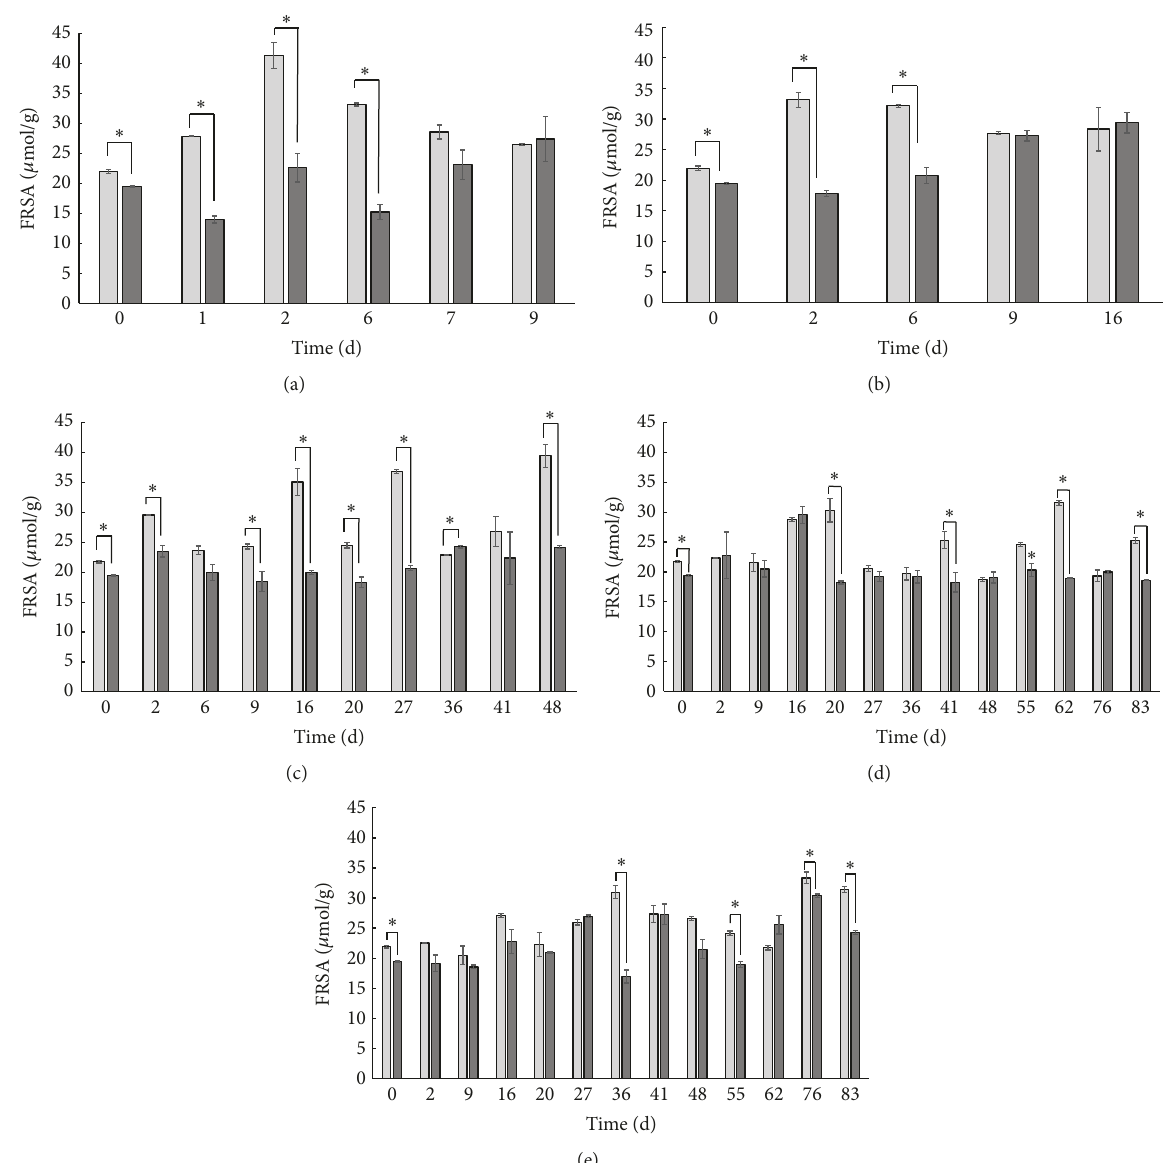
Figure 1: Evolution of the free radical scavenging ability (FRSA) in blanched (dark bars) and unprocessed (light bars) broccoli florets during storage at 20 ∘ C (a), 10 ∘ C (b), − 1 ∘ C (c), − 21 ∘ C (d), and − 45 ∘ C (e). Significant differences ( 𝑝 < 0.05 ) between blanched and unprocessed broccoli are highlighted with “ ∗